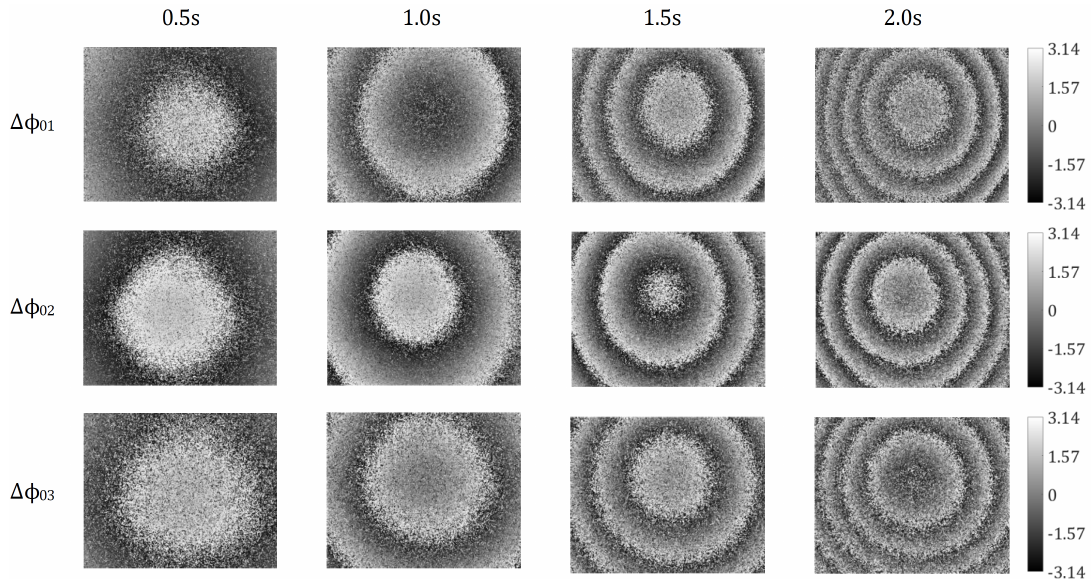
Figure 8. Wrapped phase change maps ∆ φ 01 , ∆ φ 02 and ∆ φ 03 obtained from a dynamic measurement, in which the test object was under a continuous loading